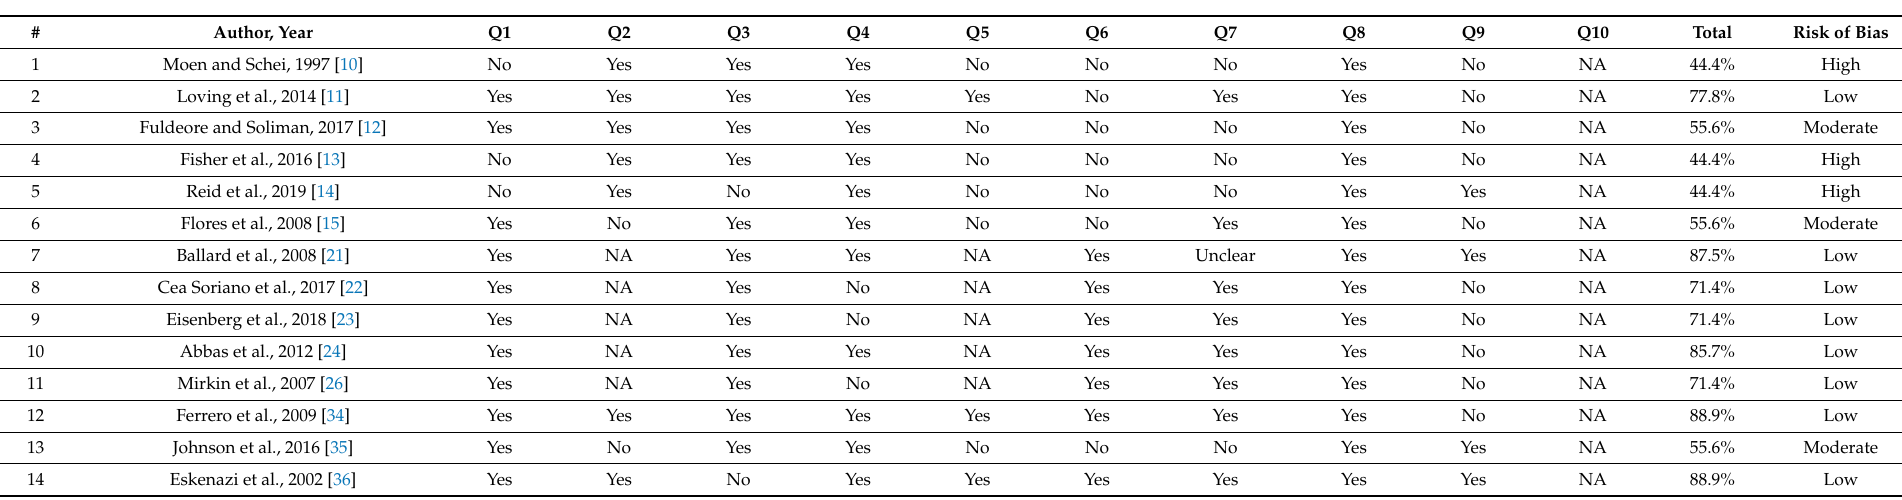
Table 6. Results from the Joanna Briggs Institute Critical Appraisal Checklist for studies reporting